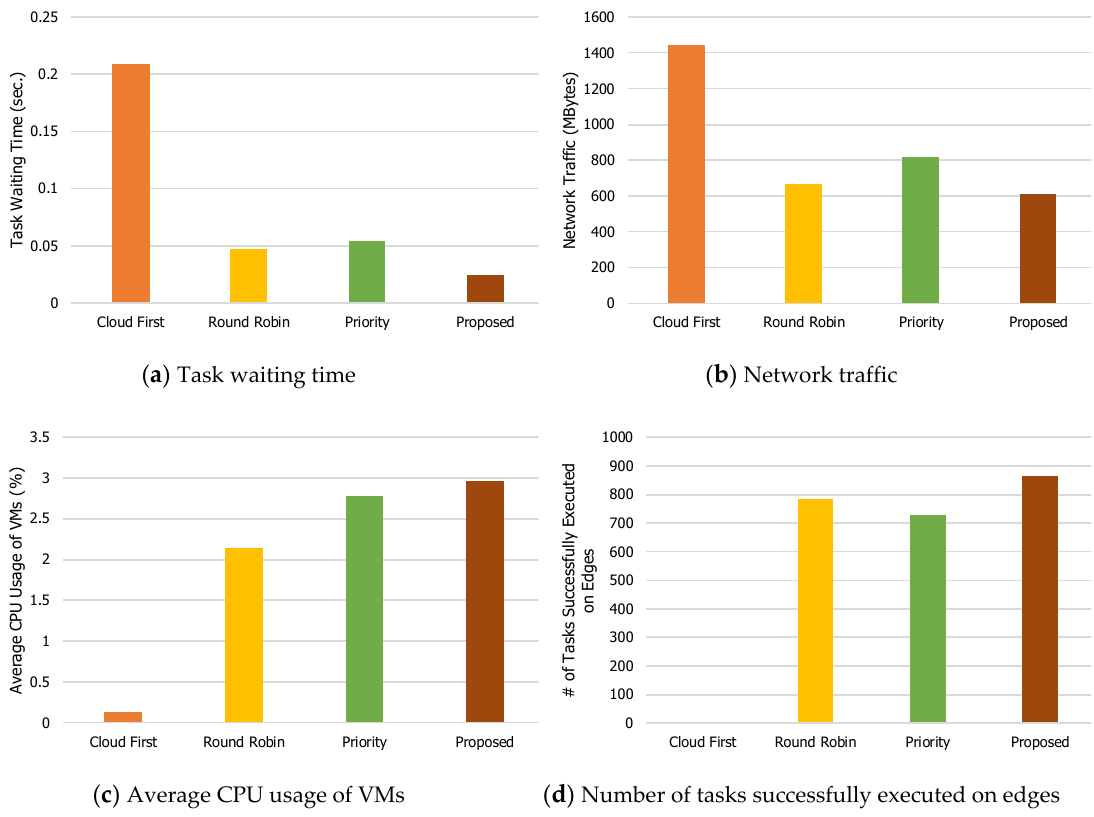
Figure 4. Performance comparisons when the number of mobile devices is 200.